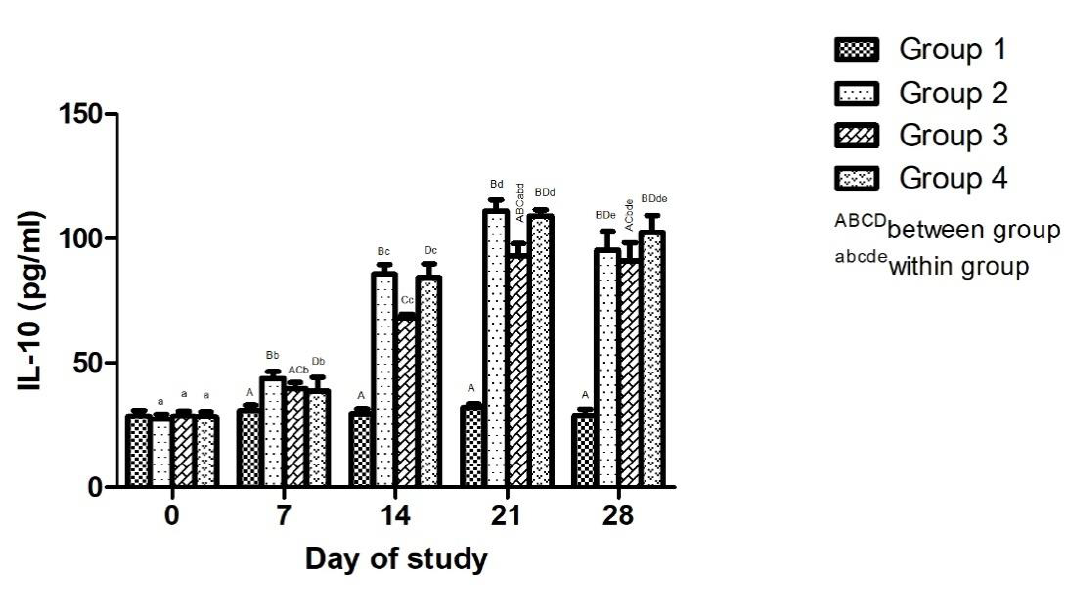
Figure 3. Effect of adjuvanted, sonicated antigens on levels of interleukin10 (IL-10) (pg/mL) in rabbits. Effect of Adjuvanted, Sonicated Antigens on Delayed Type of Hypersensitivity (Ear Thickness)